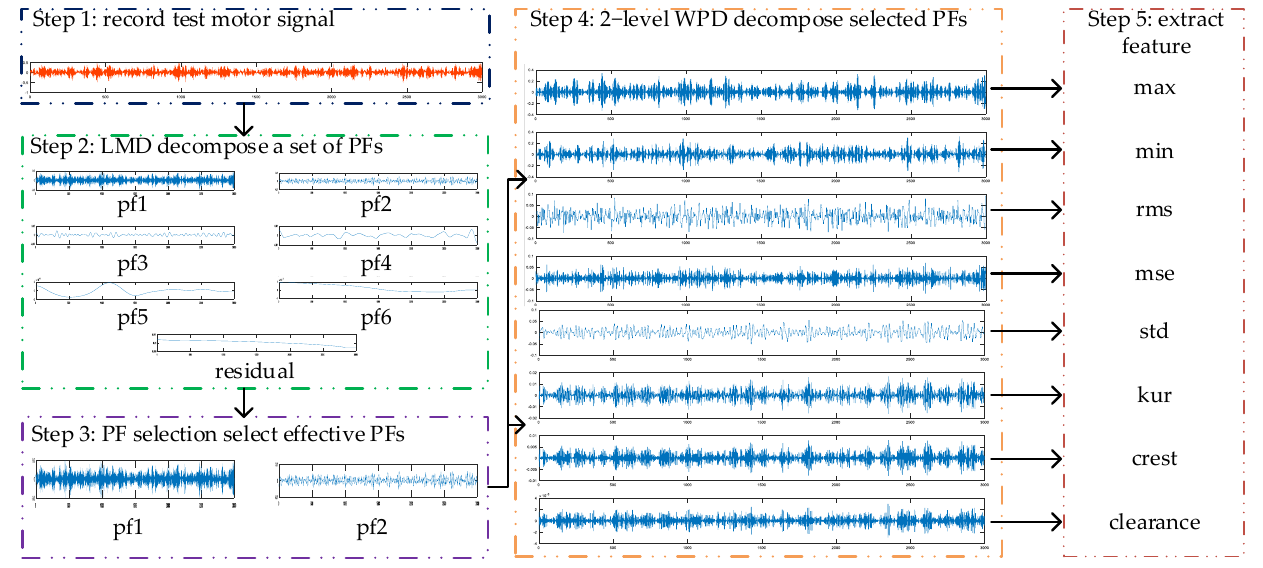
Figure 1. Feature extraction process.